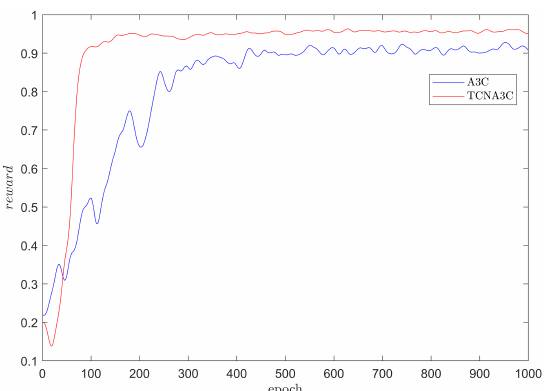
Figure 8. The comparison between TCN enabled A3C and fully-connected